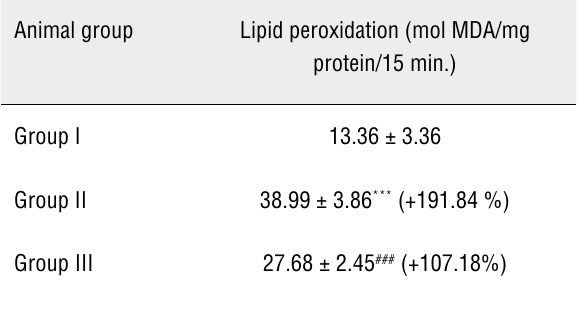
Figure 1 - Effect of various treatment on the expression level of different antioxidant enzymes ( SOD, CAT and